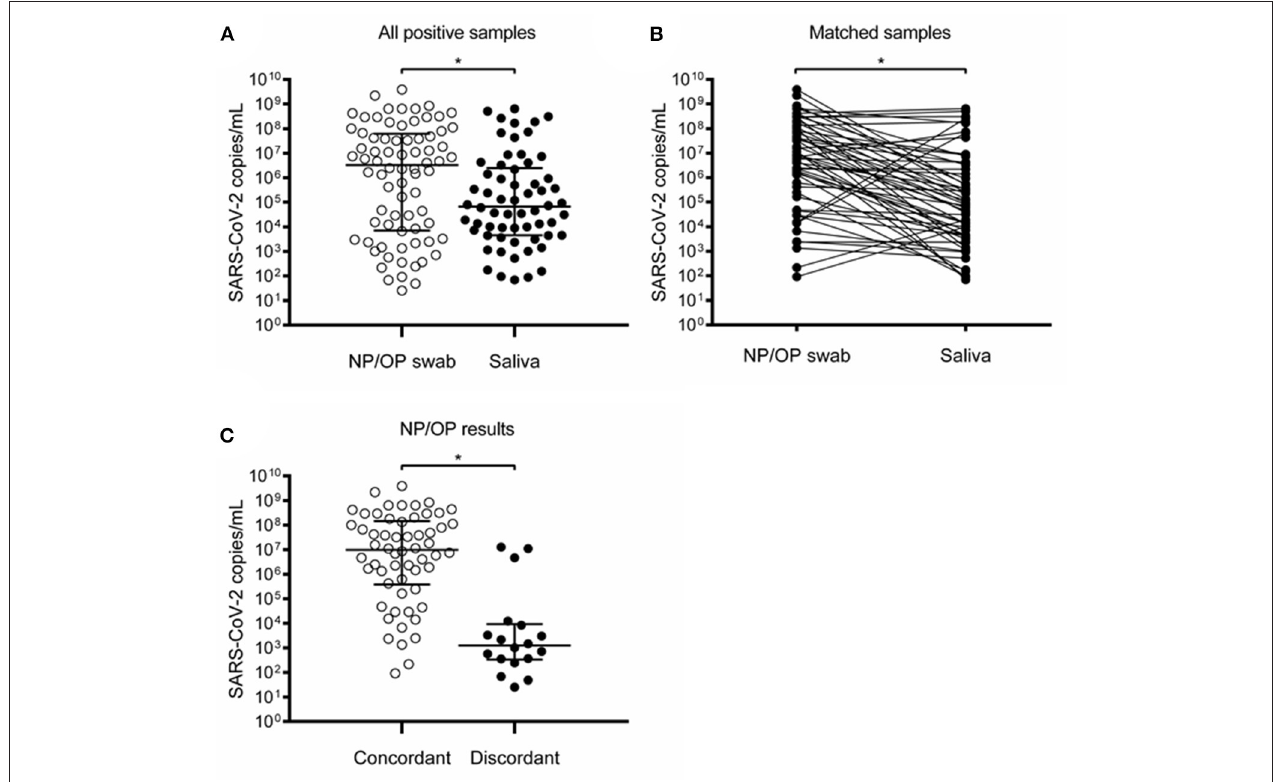
FIGURE 5 | Detection of SARS-CoV-2 in NP/OP swabs and saliva of adults. (A) All positive samples in NP/OP swab ( n = 81) and saliva ( n = 63) ( p = 0.0161), bars represent median and 25–75 percentiles. (B) Matched samples ( n = 63) ( p = 0.0001). (C) Viral loads of concordant ( n = 63) and discordant ( n = 18) NP/OP swab samples ( p < 0.0001). Data in (A,C) were compared with Mann–Whitney test. Data in (B) were compared with Wilcoxon test. *Statistically significant ( p < 0.05). TABLE 5 | Viral loads and concordance rates in variables with significant differences among adult participants who tested positive in the NP/OP swab. Participants Viral load in NP/OP swab Viral load in saliva Number of positive saliva samples